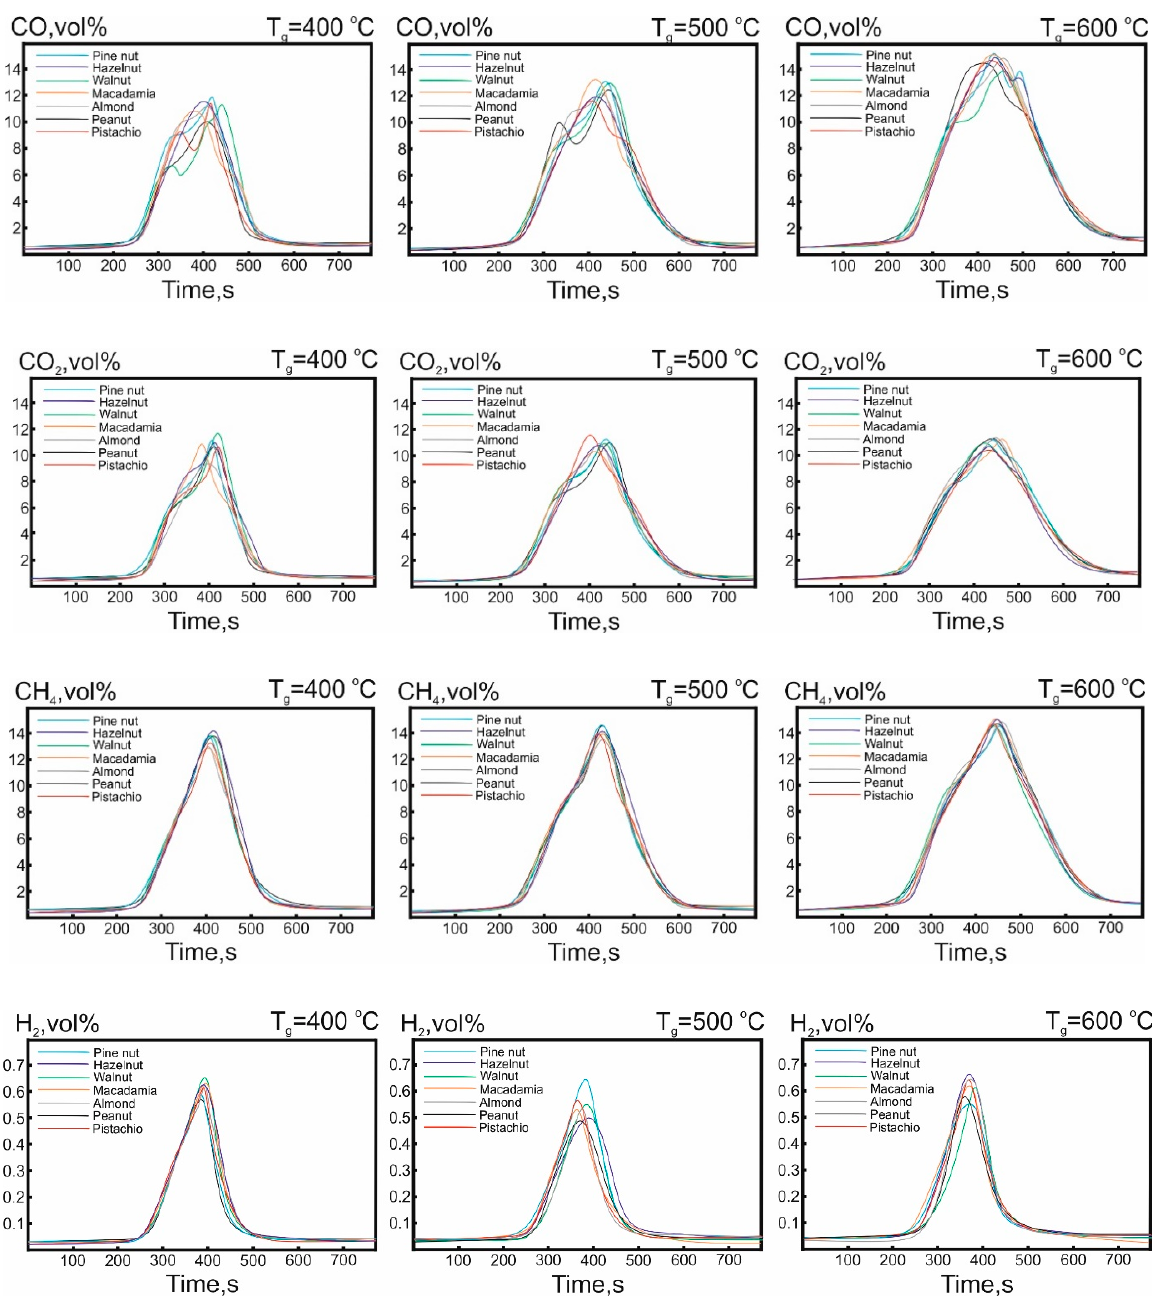
Figure 5. Concentration curves of the formed compounds CO, CO 2 , CH 4 , and H 2 in the non-condensing gas-phase products, of the pyrolysis of the nutshell, at different temperatures of the heating medium (T g = 400–600 °C).